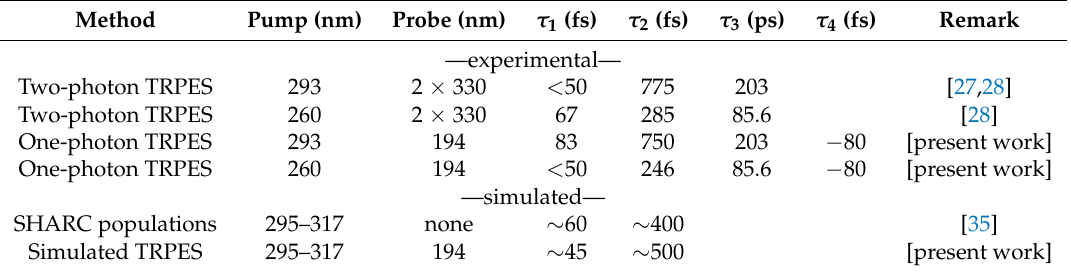
Table 1. Time constants a for the excited-state dynamics of 2TU obtained with time-resolved photoelectron spectroscopy (TRPES) and nonadiabatic SHARC (surface hopping including arbitrary couplings) dynamics